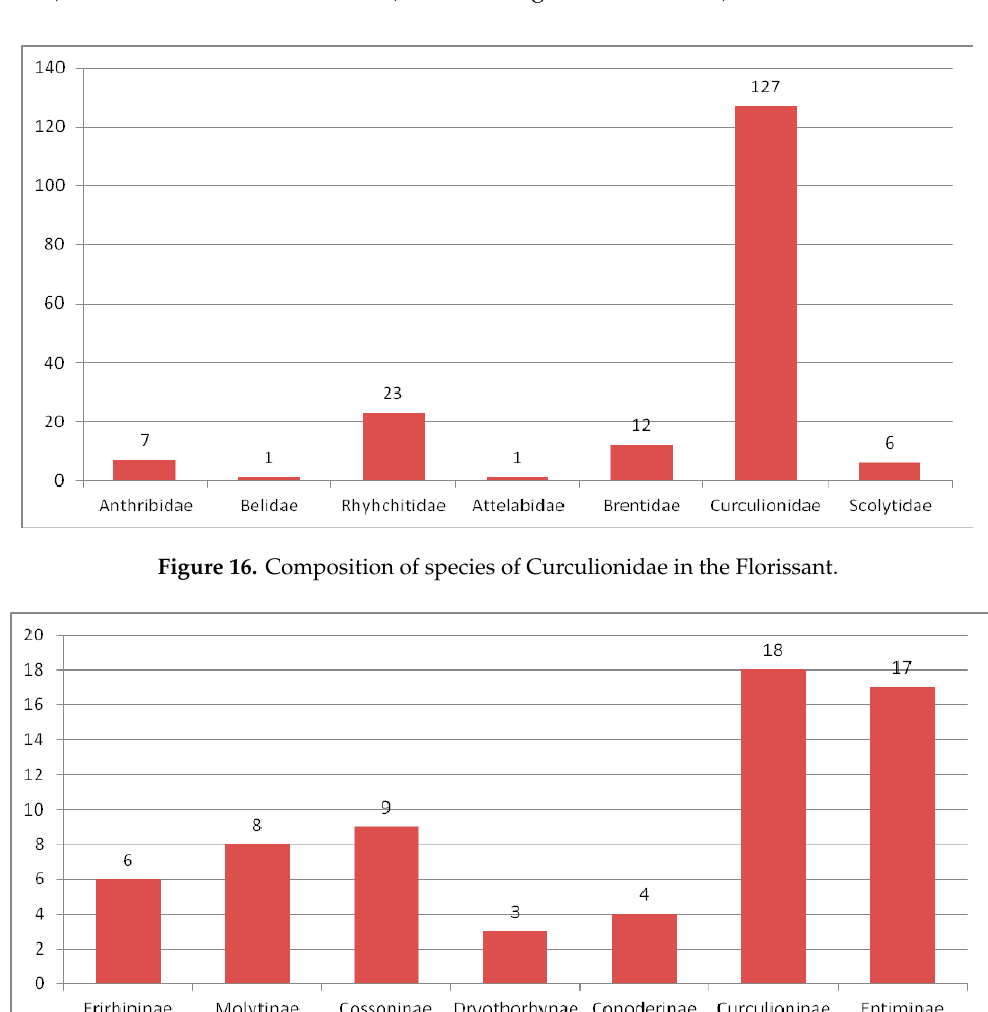
Figure 15. Composition of species of Curculionoidea in the Florissant.